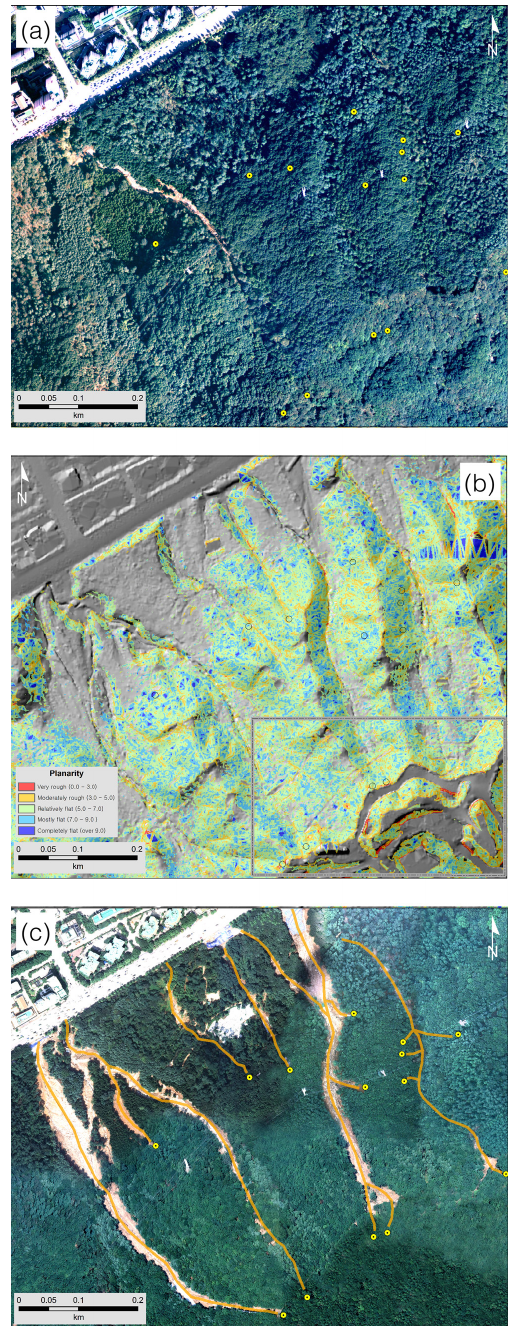
Figure 10. Feasibility evaluation of planarity in Site A. (a) Aerial photograph before the landslide (2009). Yellow circle with dot rep- resents the landslide initiation zone. (b) Modified planarity: areas outlined by a black circle with a diameter of 5m are the landslide initiation zones. A rectangle with a dotted line and a grey shade indicates a closer look at the representative area shown in Fig. 14. (c) Aerial photograph after the landslide (2011). Orange lines indi- cate observed landslide routes from the landslide initiation zones.